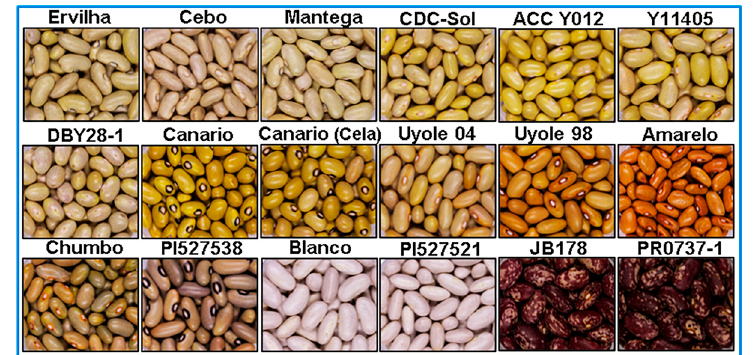
Figure 1. High-resolution photographs depicting the eighteen genotypes of the Yellow Bean Panel (YBP) arranged in order from lightest to darkest yellow seed coat color, followed by the white and red mottled controls. To compare differences in seed sizes, all photographs were taking to scale under standardized lighting conditions.